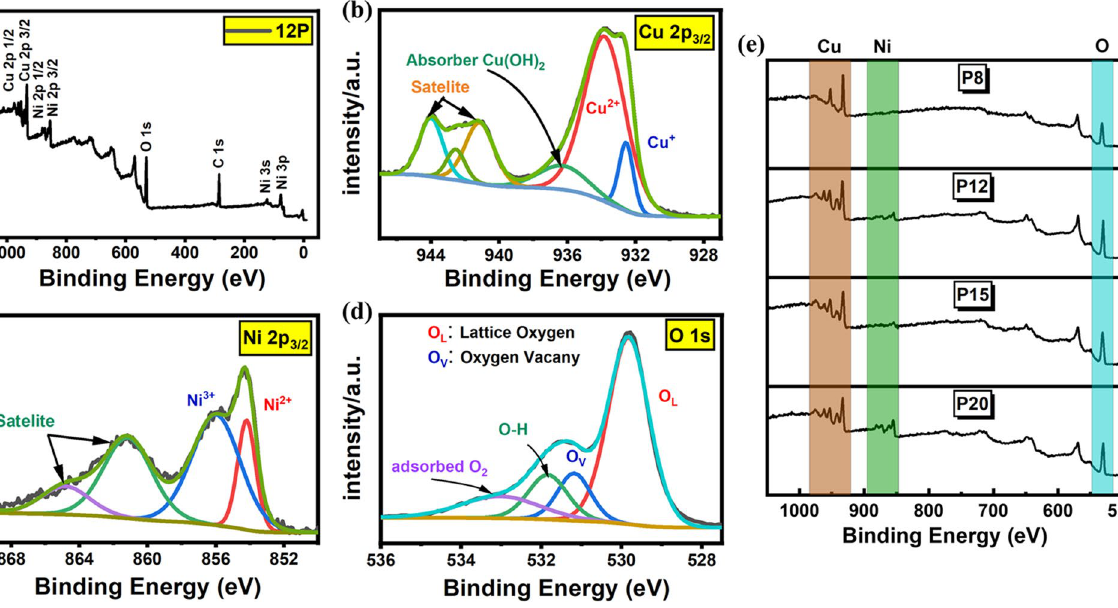
Figure 4. ( a ) XPS survey to define material composition ( b ) High-resolution XPS for Cu 2p 3/2 ( c ) High resolution of XPS of Ni